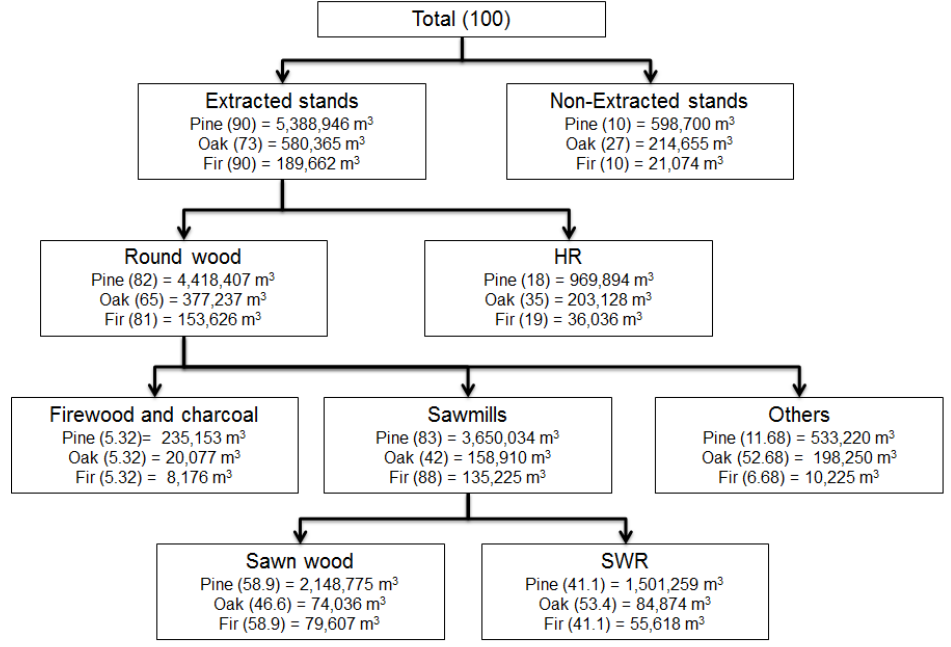
Figure 7. Breakdown of biomass production for energetic use showing residues origin from the 10 analyzed provinces. Notes: “Total” refers to total available woody biomass as standing volume from the 10 analyzed provinces in 2013. The values in parentheses are percentages of the previous category. HR: residues coming from harvesting activities. SMR: produced residues after sawmill processes. Non-extracted stands, as available but not utilized resources, are considered to be a plus for biomass utilization.